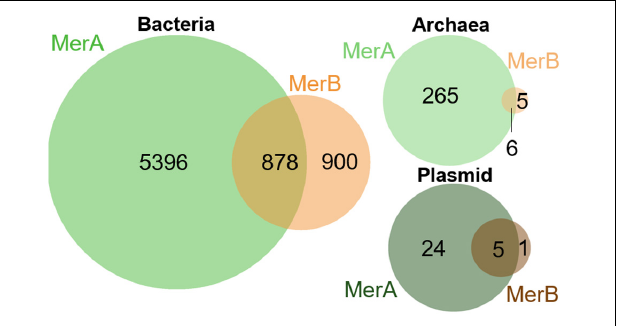
FIGURE 2 | Venn diagrams reporting the number of genomes with MerA and/or MerB protein homologs. Analyzed genomes included those from Bacteria, Archaea, and plasmids that encode only MerA homologs, only MerB homologs, or that encode both MerAB. The number of genomes in each category is